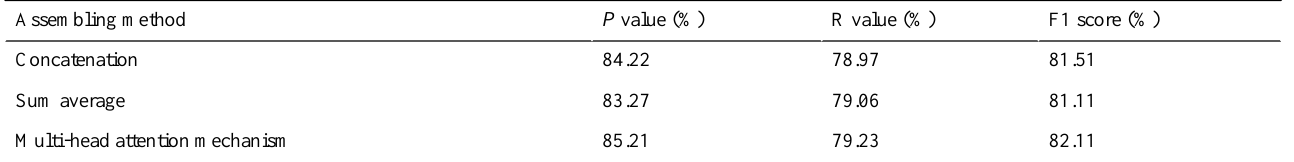
Table 5. The effect of assembling methods.